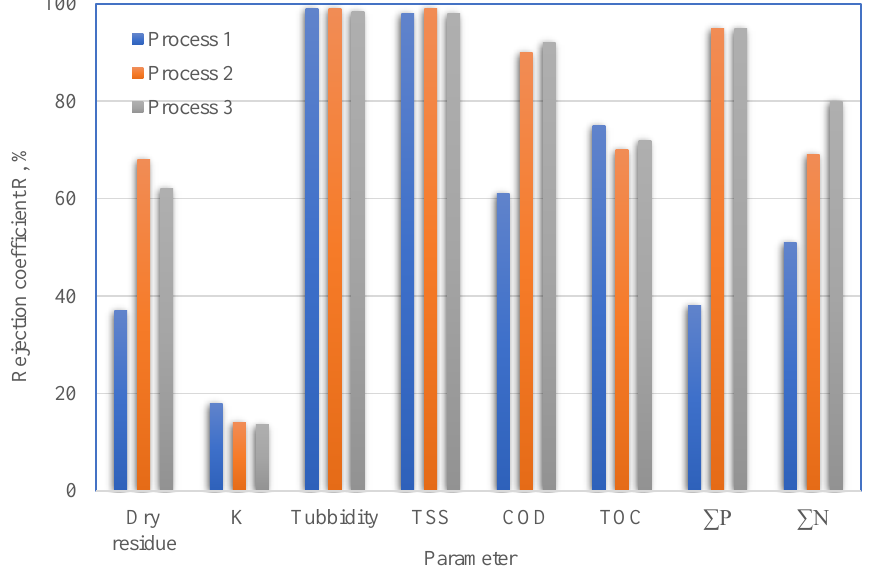
Figure 8. Rejection coefficients vs. physicochemical parameters of PPW treated by UF using a new (process 1) or regenerated (processes 2 and 3) membrane.